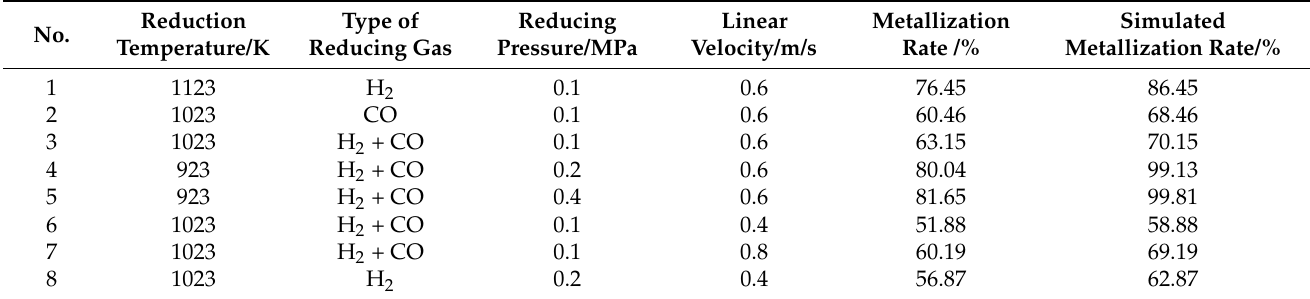
Table 5. Experimental scheme and